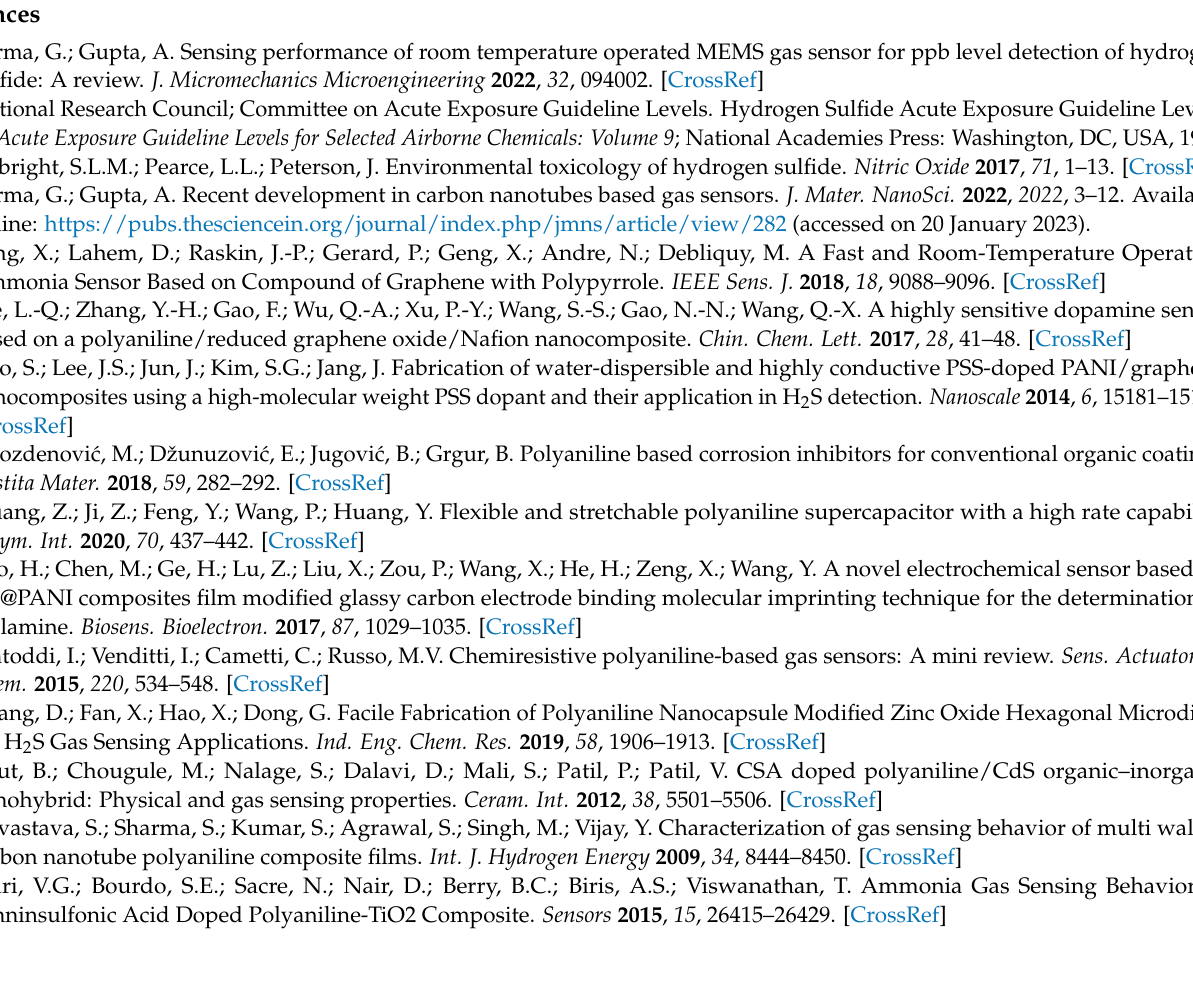
aniline trimer (ACAT); Figure S2: The representative FTIR spectrum and mass spectrum of ACAT; Figure S3: Response time (a) and recovery time of PUU-AC0, PUU-AC1 and PUU-AC3 sensors towards H 2 S gas concentration ranging from 1-50 ppm at room